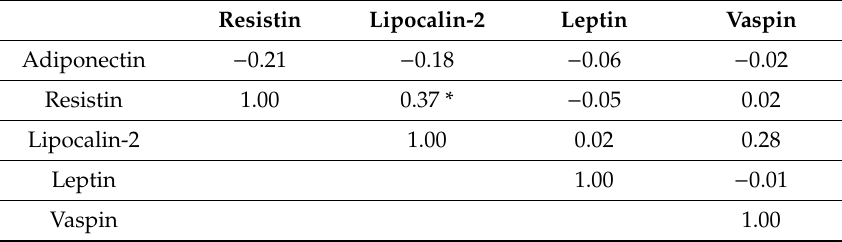
Table 3. Associations among adipokine biomarkers in atopic dermatitis patients.